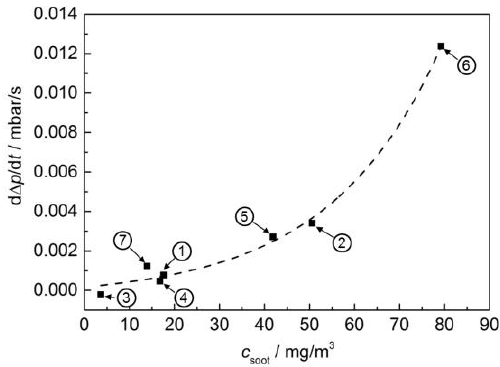
Figure 8. Time derivative of the differential pressure (normalized to exhaust flow) over the averaged soot mass concentration in the exhaust upstream of the DPF as determined by the Pegasor sensing device. Each point was obtained from one of the operation points ① to ⑦ , as indicated in Figure 4. The exponential equation d p /d t /(mbar/s) = 5.29354 × 10 −4 · exp(− c soot /(mg/m 3 )/24.93527) − 3.58073 × 10 −4 was used for regression (dashed).